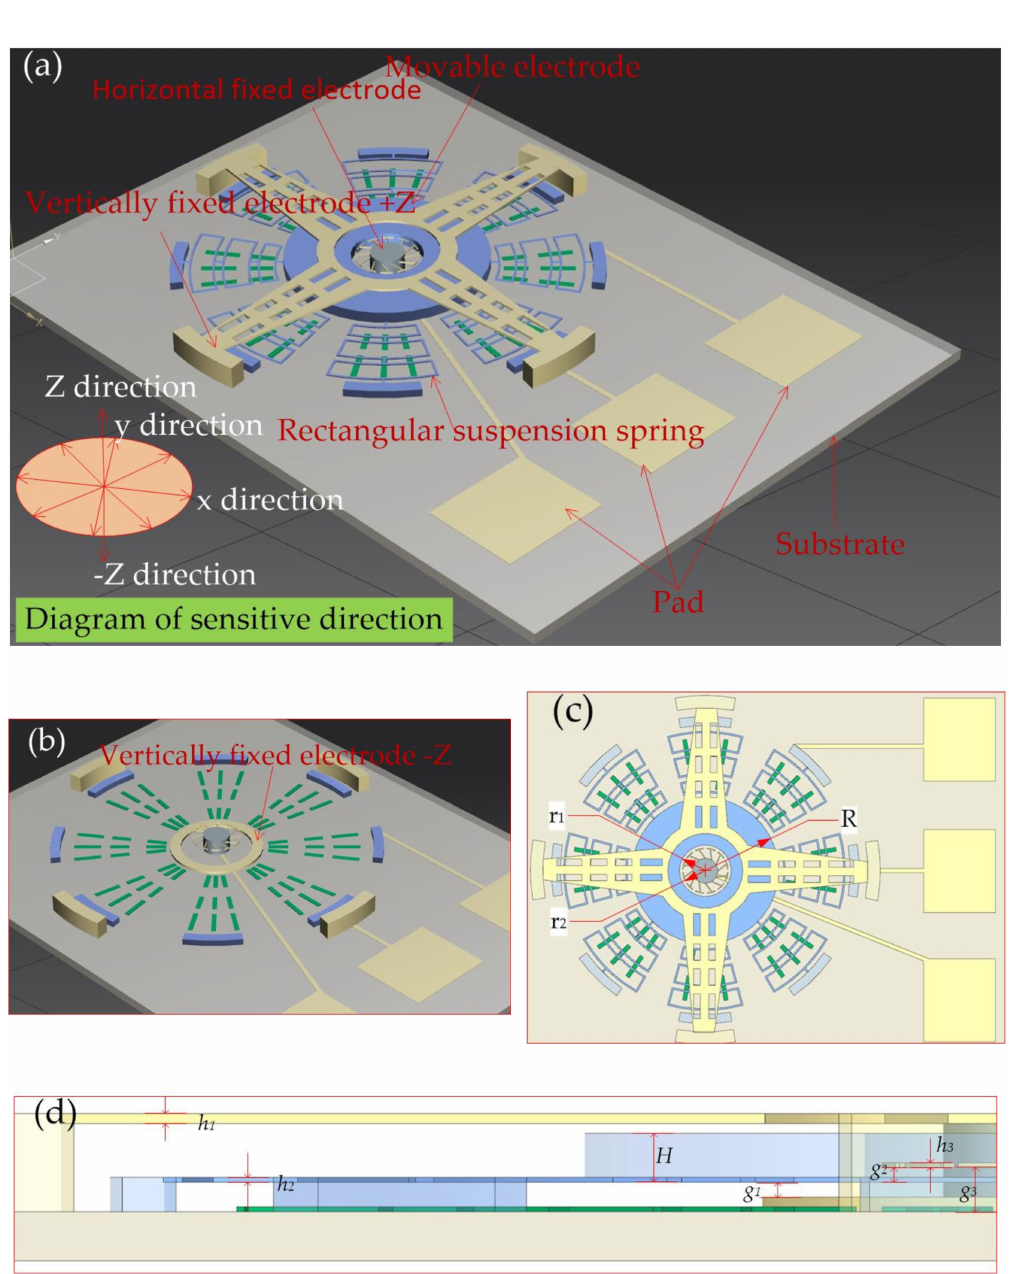
Figure 3. ( a ) The 3D structure of the designed inertial switch; ( b ) The schematic diagram of the fixed electrode; ( c ) The top view of the inertial switch structure; ( d ) The side view of a half